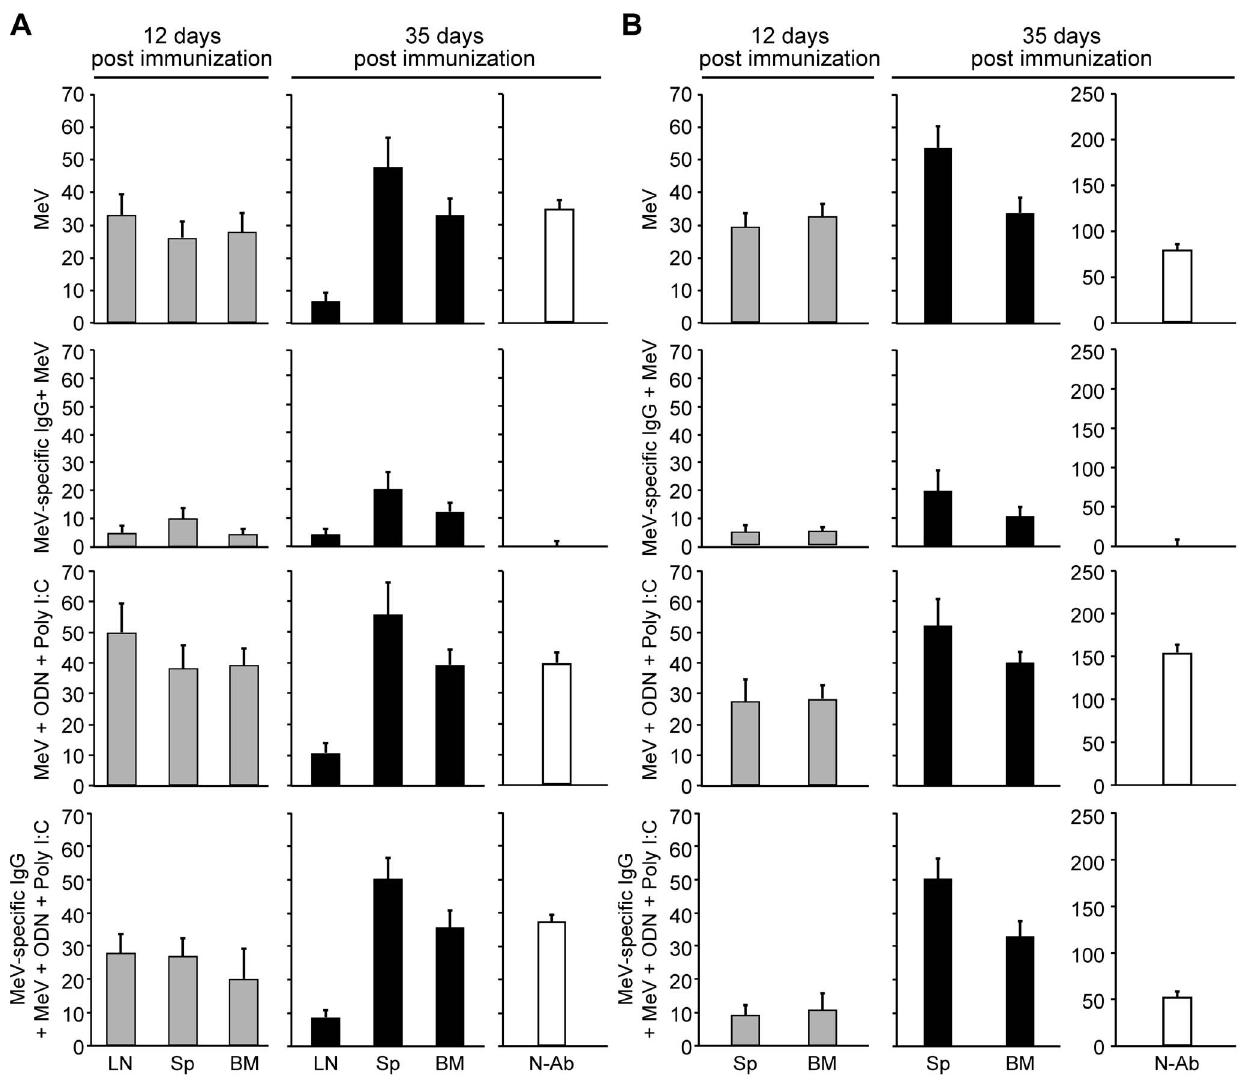
Figure 5. Kinetic of B cell generation is restored to normal levels in the presence of MeV-specific IgG after co-immunization with ODN 2216 and poly I:C. Groups of cotton rats were immunized with 10 5 pfu MeV vaccine alone or with the combination of ODN2216 (50 m g) and poly I:C (50 m g) in the absence or presence of MeV-specific IgG. At 12 days and 35 days post vaccination, generation of MeV-specific B cells in the lung draining mediastinal lymph nodes (LN), spleen (Sp) and bone marrow (BM) and induction of neutralizing antibodies (N-Ab) after immunization by the intranasal route (A) or by the subcutaneous route (B) were measured by B cell ELISPOT and neutralization assay. Each bar graph represents the average of four animals 6